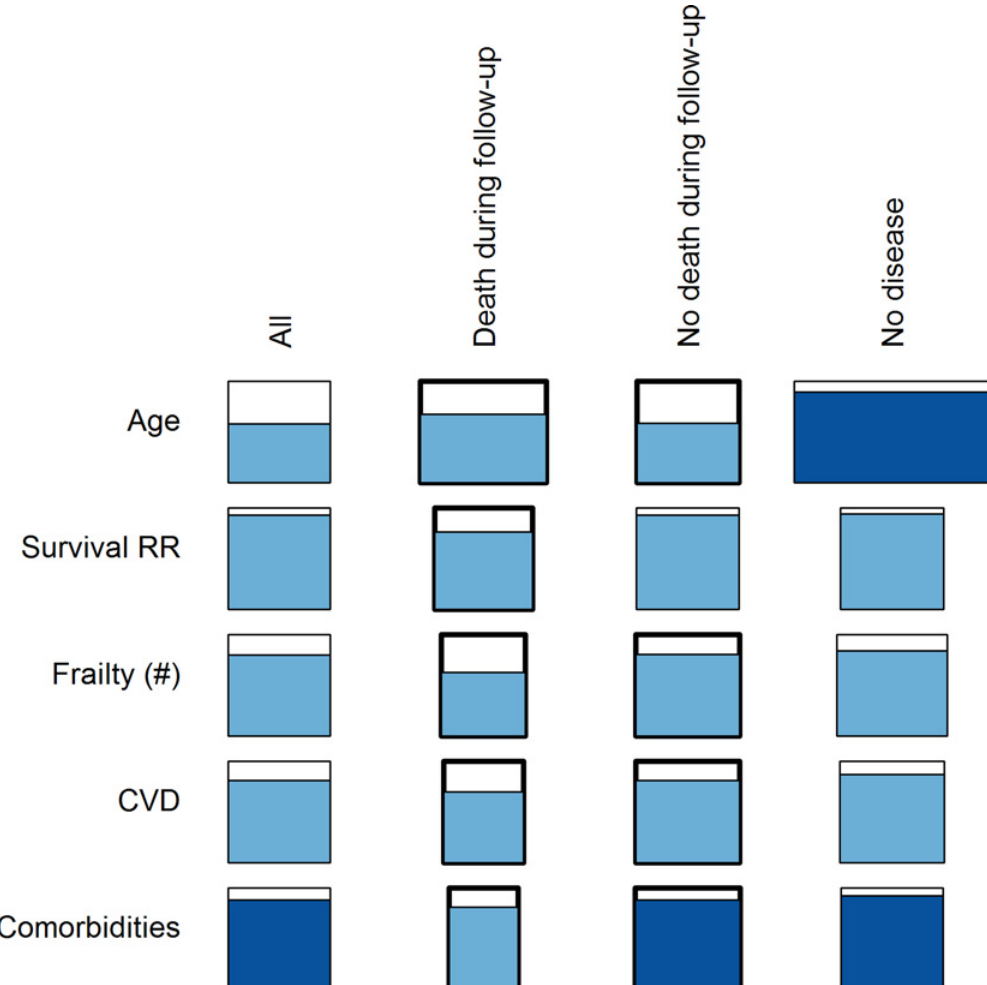
Fig 7. Effects of RPs ’ survival and health status on prediction of age and health outcomes. The study population represented here is the full InCHIANTI data set with InCHIANTI RPs defined according to survival and health status. The width of the rectangle represents the average effect size among significant analyses, relative to the effect size of the rectangle in the leftmost column (entire study population as its own RP). The percentage of significant p- values is represented by the height of shading within the rectangle, the shading colour represents the direction of the effect (blue is a positive effect), and the hue represents the average p -value among the significant p-values, with darker hues indicating lower p